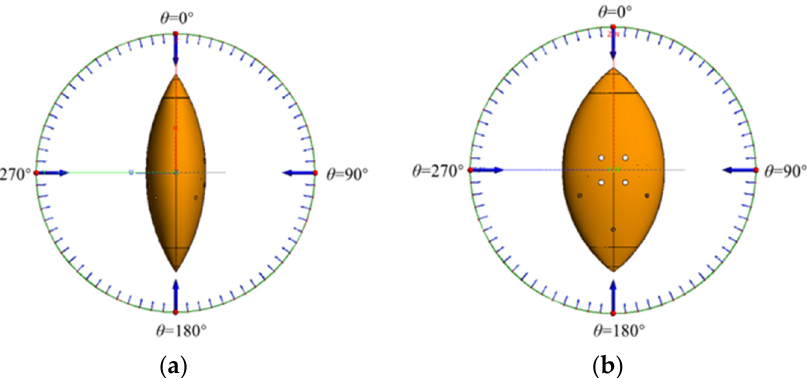
Figure 3. Two radar wave incident attitudes of Olive-A configuration. ( a ) Incident in non-stealth attitude. ( b ) Incident in stealth attitude.